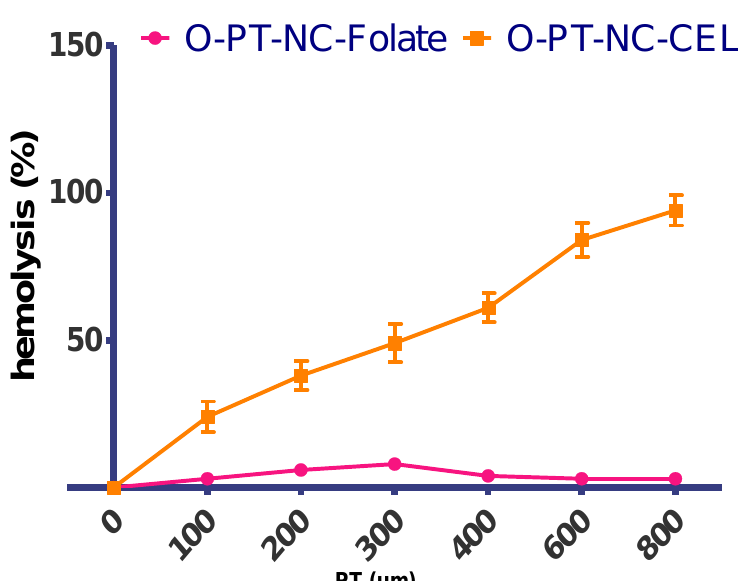
Figure 8. Hemolysis activity of the O-PT-NC-Folate and O-PT-NC-CEL. There was evidence of hemolytic activity in the erythrocyte suspensions collected from mouse blood (n = 3, mean SD).